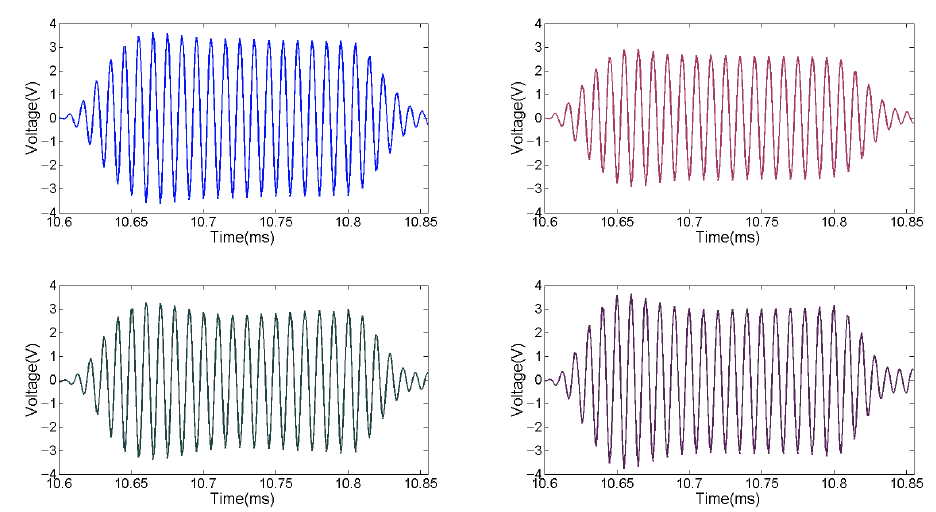
Figure 13. Echo signal acquisition of module #8.